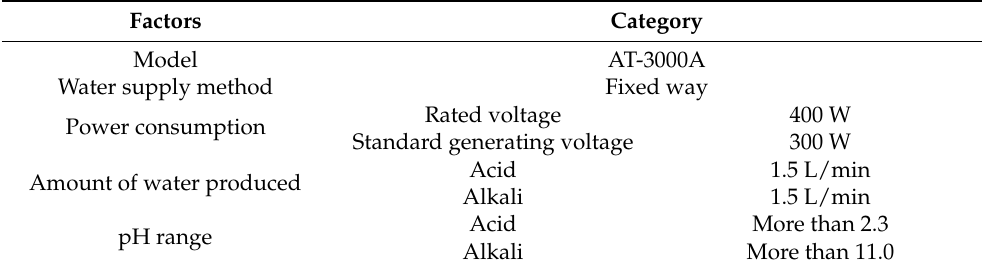
Table 5. Specifications of the equipment used to produce the alkaline aqueous solution.